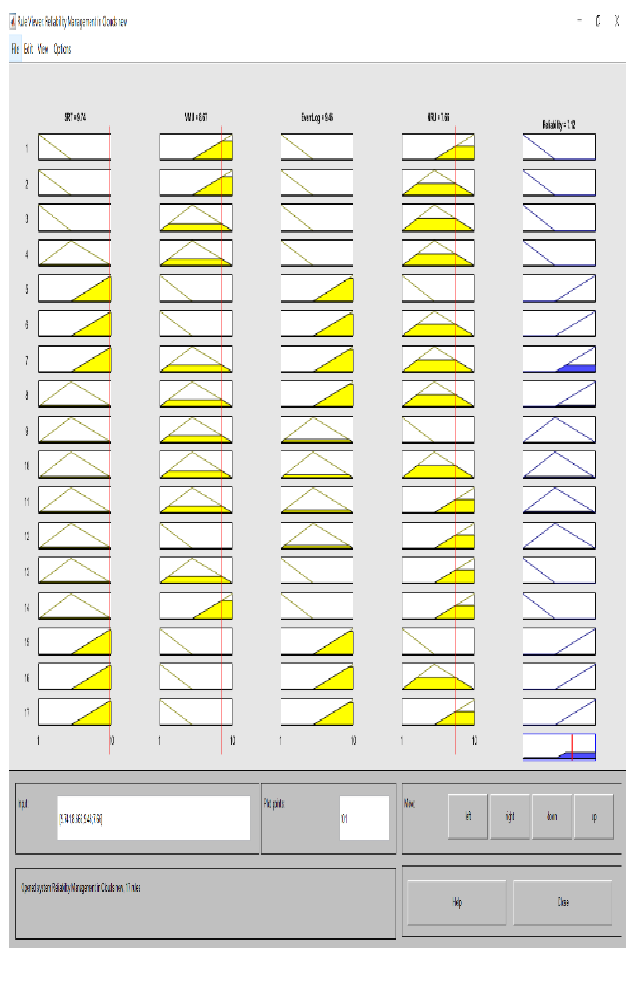
Figure 10. Lookup diagram for High Reliability